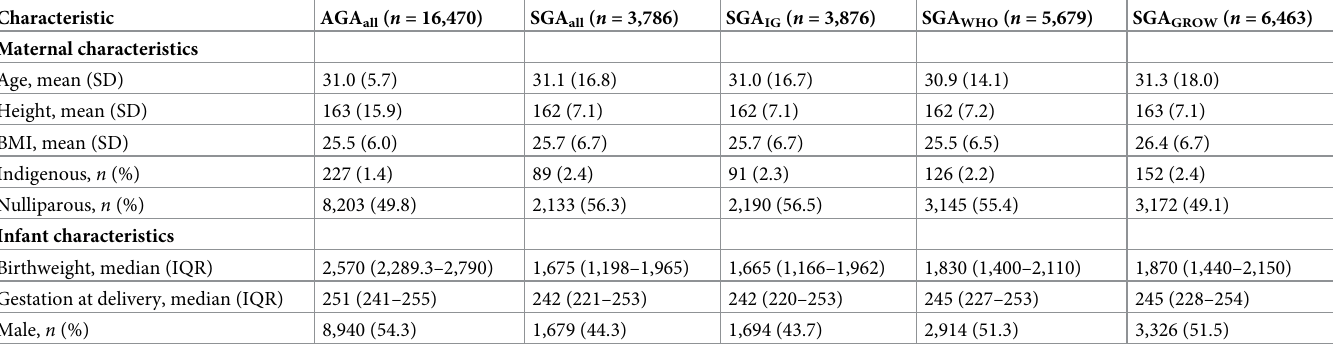
Table 2. Baseline maternal and infant characteristics for infants classified as AGA all and SGA by fetal growth charts (unadjusted data presented).